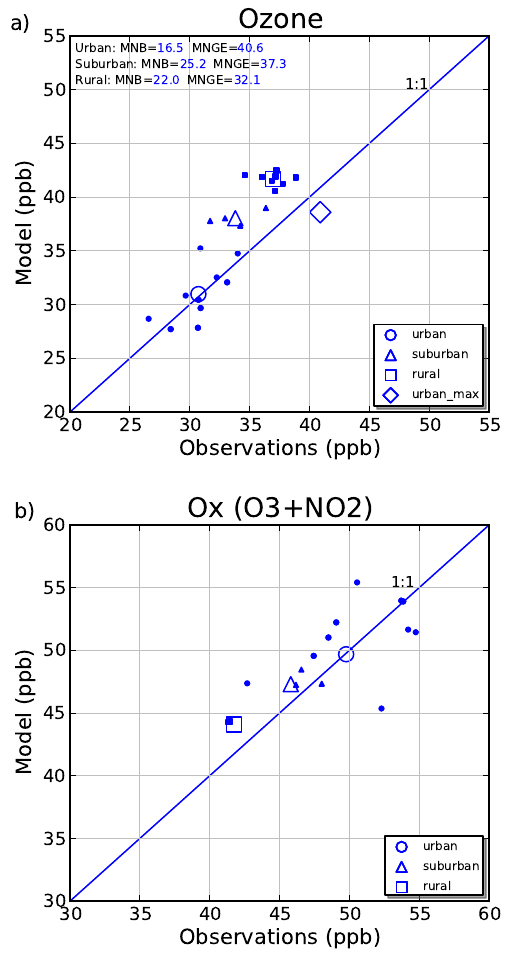
Figure 2. Scatter plots of mean daytime ozone (a) and O x (b) dur- ing the April to August period from the model run against obser- vations. Small solid markers represent concentrations at individual stations while large hollow markers stand for the aggregated value. “Urban_max” stands for the daily maximum of an 8hr running av- erage.